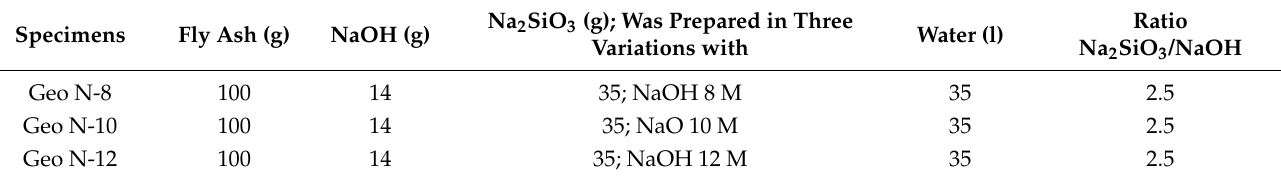
Table 2. Mix proportion of geopolymer pastes.